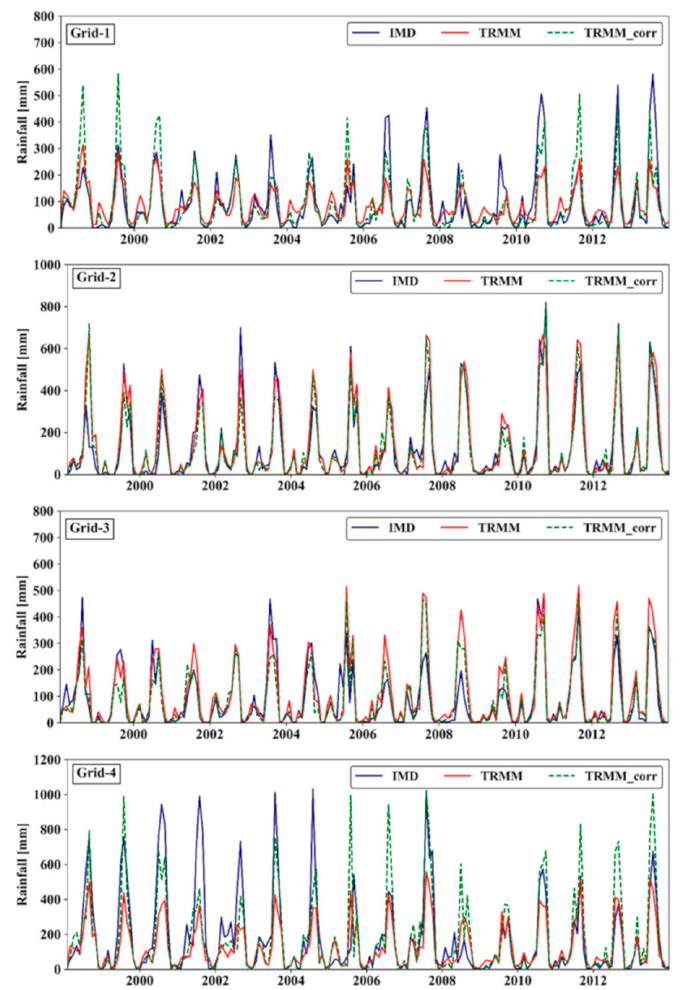
Figure 7. Comparison of time series of IMD, TRMM and bias corrected TRMM precipitation at Grid-1 (North), Grid-2 (West), Grid-3 (South) and Grid-4 (East) in the Upper Ganga